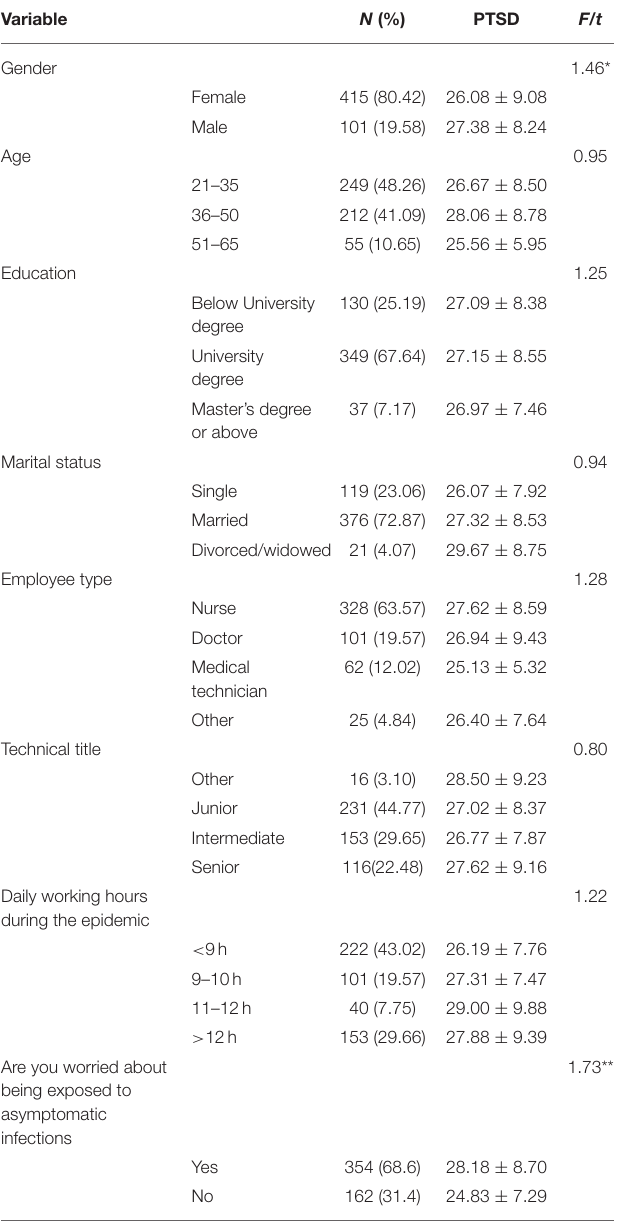
TABLE 1 | Demographic characteristics of the participants and associations with PTSD ( n = 516).